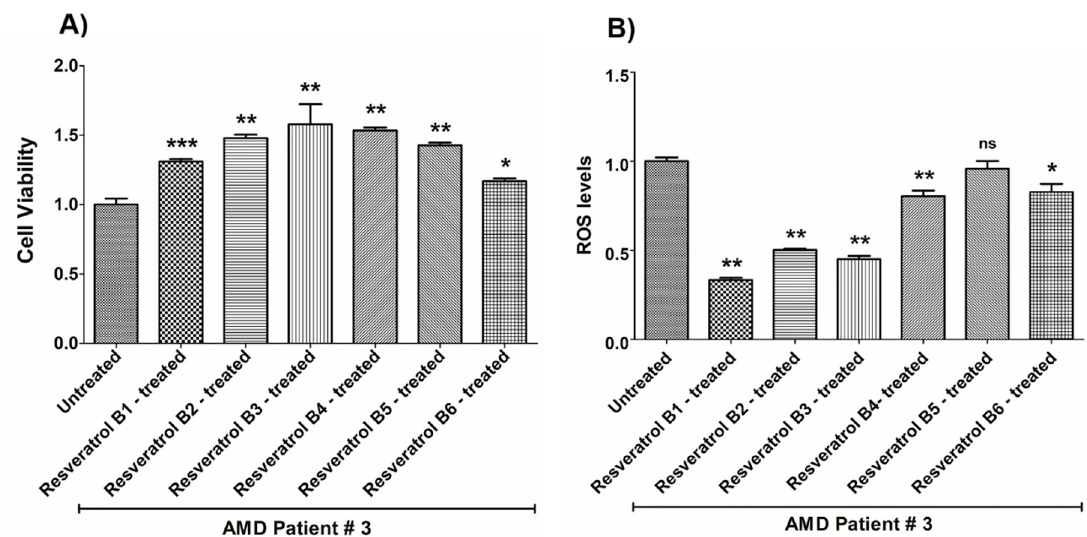
Figure 3. Effects of resveratrol formulations on cell viability ( A ) and ROS levels ( B ) in AMD patient